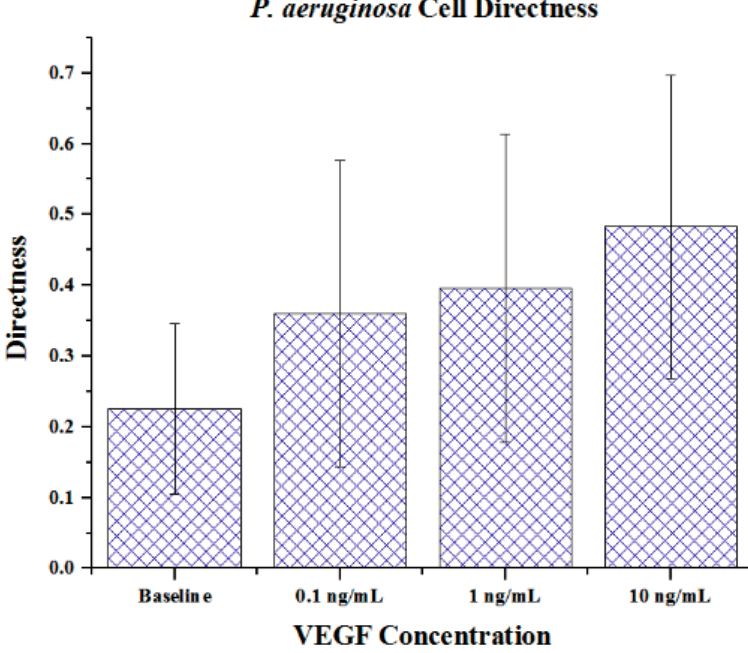
Figure 6. The directness of P. aeruginosa BK-76 cells in VEGF concentration gradients. Increasing FMI X values indicate that cell groups had more direct paths with regards to migrating along the VEGF concentration gradient (towards highest concentration). Error bars show standard deviation.